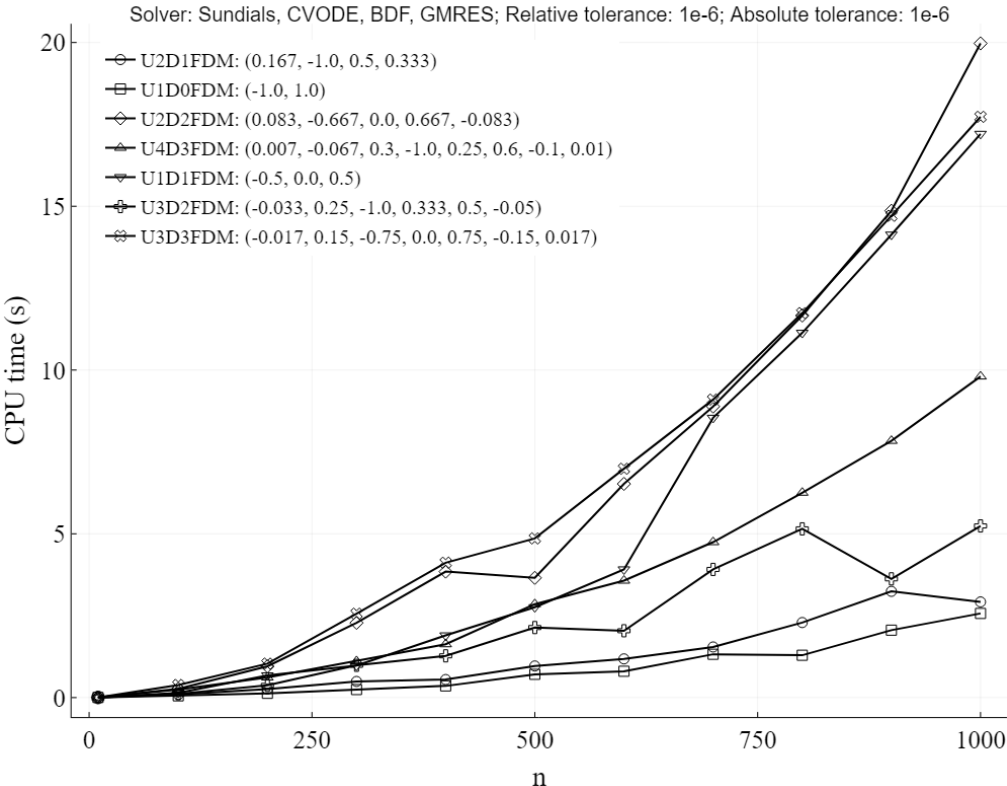
Figure 3. Comparison of computational time of the tests between upwind-biased and central schemes for FDM. Similar results can be observed for FVM. The values in brackets represent rounded row stencil coefficients in the typical row of the derivative operator A (when Δ x = 1).